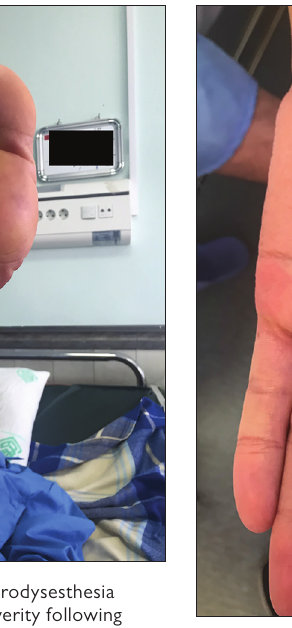
Figure 3. Hand of the patient after PPES